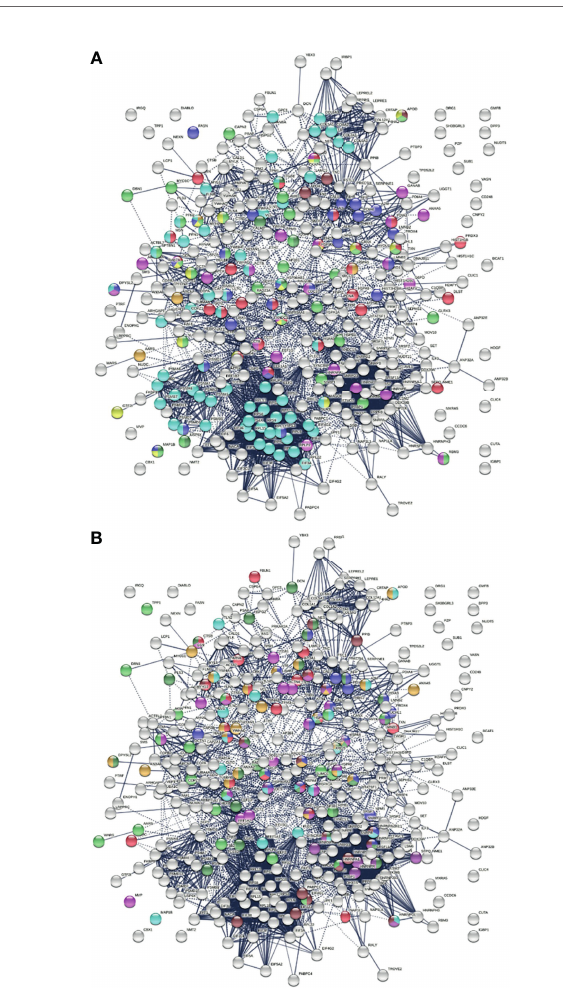
FIGURE 5 | (A) Relation of COVID-altered proteins to wound healing and hemostasis. Response to wounding (25 proteins, red), blood vessel development (20 proteins, pink), blood coagulation (14 proteins, blue), collagen-containing extracellular matrix (13 proteins, brown), collagen biosynthesis and modifying enzymes (16 proteins, dark purple), platelet activation (3 proteins, dark green) and platelet activation signaling and aggregation (22 proteins, green), platelet degranulation (18 proteins, aqua), and hemostasis (35 proteins, gold). (B) Other signi fi cantly enriched groups among altered proteins. Supramolecular fi ber (56 proteins, amber), melanosome (30 proteins, brown), striated muscle cell differentiation (11 proteins, purple), myo fi bril (23 proteins, red), muscle structure development (18 proteins, green), muscle contraction (13 proteins, aqua), Z disk (9 proteins, dark green), intercalated disk (4 proteins, blue), and amyloid fi ber formation (6 proteins,